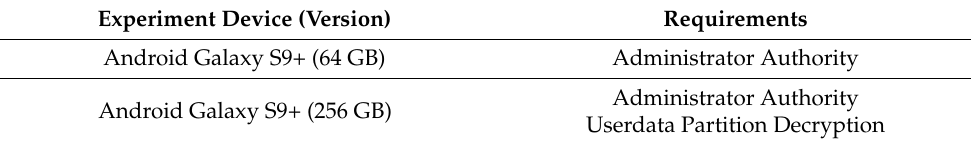
Table 7. Experimental requirements to improve user privacy.